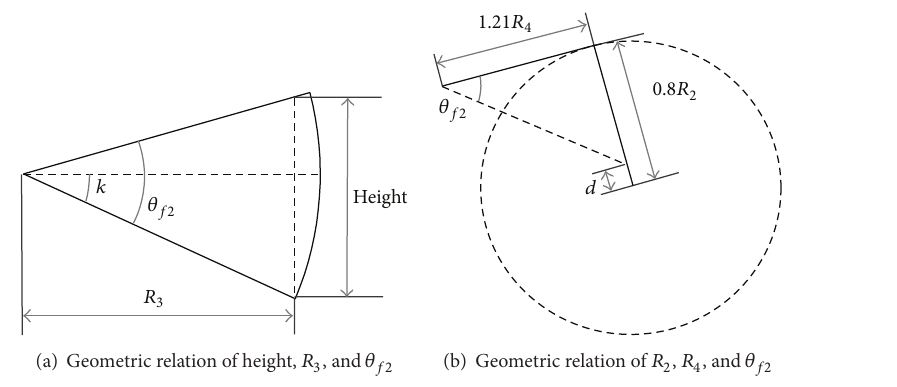
(b) Geometric relation of 𝑅 2 , 𝑅 4 , and 𝜃 𝑓2 Figure 14: Geometric relation of height and dominant distance.